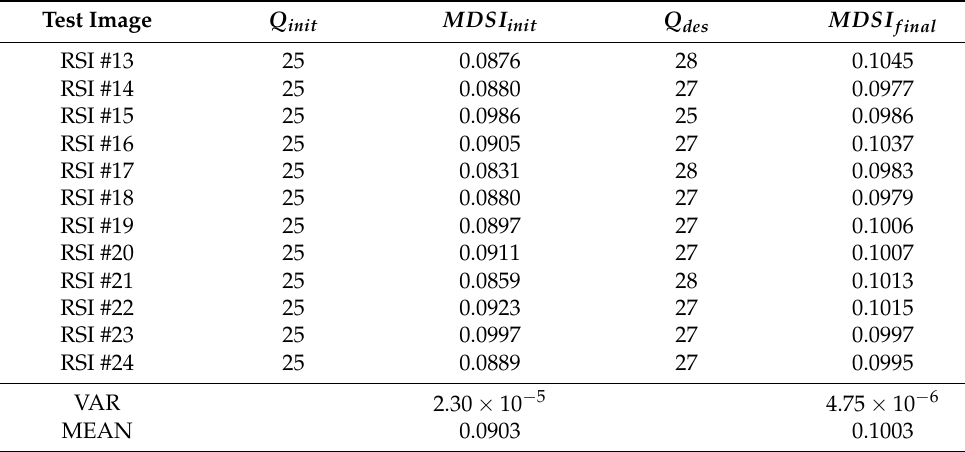
Table A7. The experimental data obtained for the test image set for the desired MDSI =